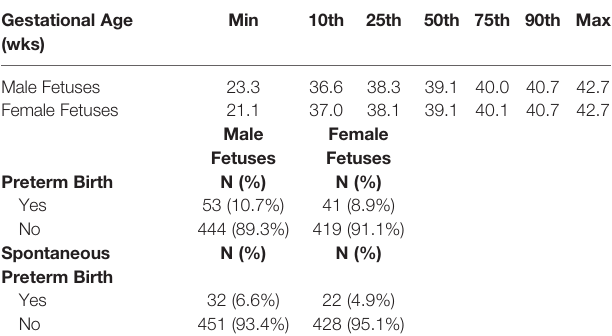
TABLE 2 | Distributions of gestational age at birth, overall preterm birth, and spontaneous preterm